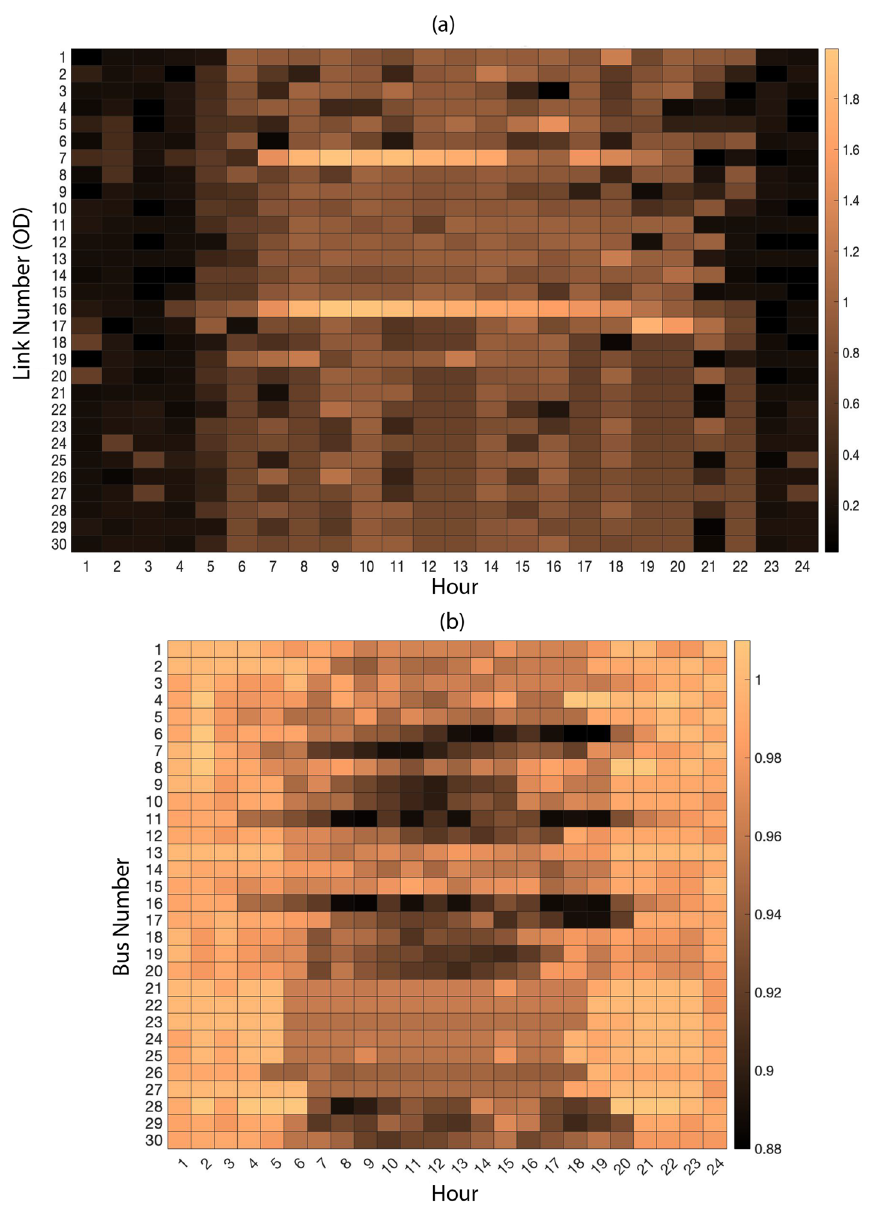
Fig. 3 a TN traffic flow (congestion levels) and b PDN bus voltage magnitude. The cascading impact of PDN bus magnitude values are shown in the heatmap (bottom) which indicates large scale traffic induced